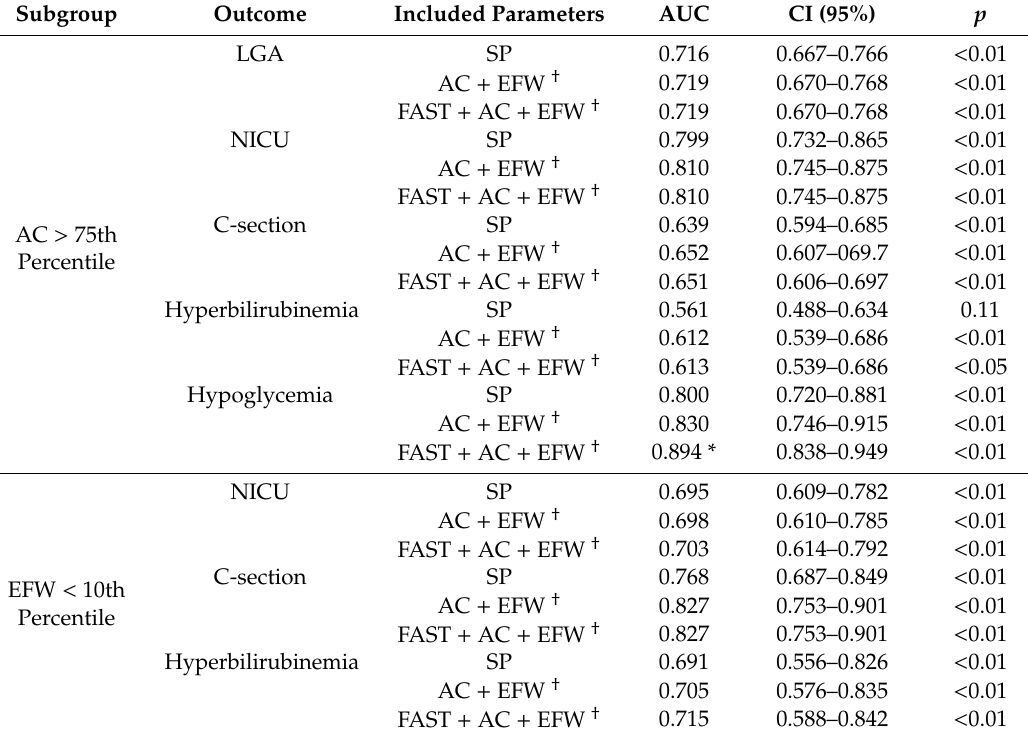
Table 5. Area under the receiver operating curve for perinatal outcome parameters (LGA, NICU, C-section, hyperbilirubinemia and hypoglycemia) in the subgroups with AC > 75th percentile or EFW < 10th percentile using combinations of clinical standard parameters and US